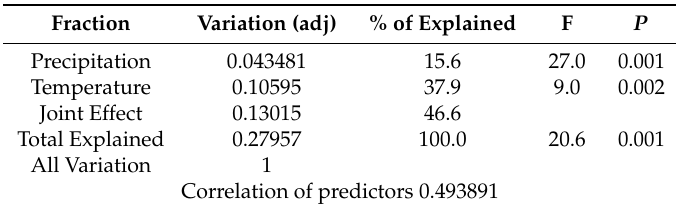
Table 3. Outcomes of RDA model (Original) over the semiarid transect.